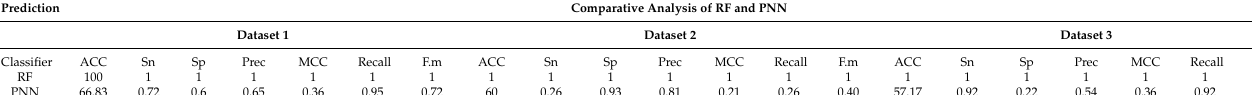
Table 10. Performance of proposed model based on RF and PNN.